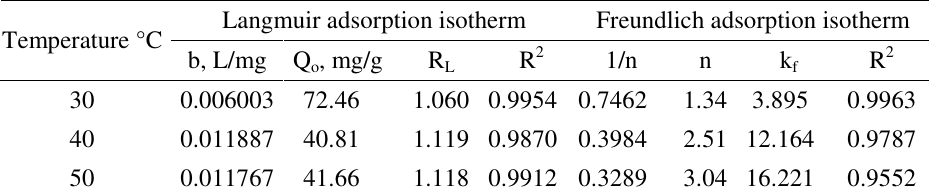
Temkin adsorption isotherm Temkin sorption potential increases with increase in temperature and reached maximum